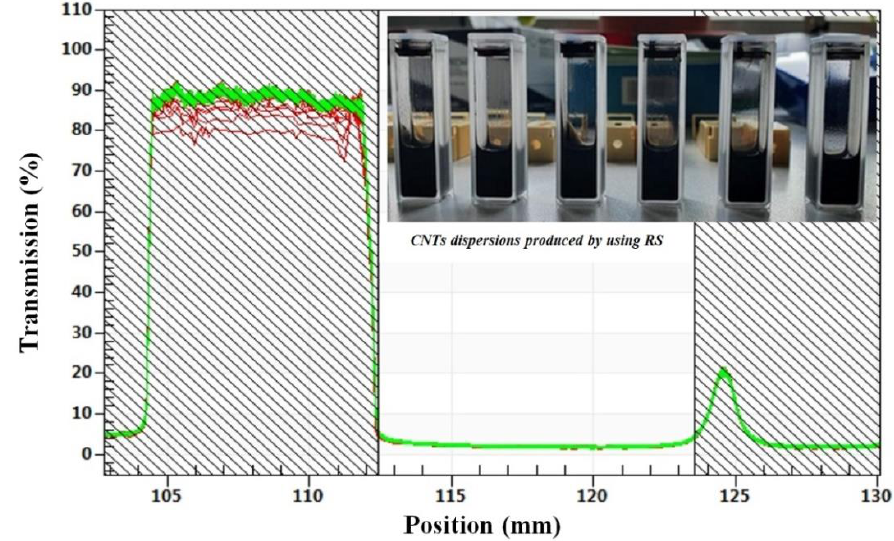
Figure 9. Transmission profiles for representative RS method CA/MWCNTs samples after centrifugation for 2.5 h in LuMiSizer equipment exhibiting no sedimentation or instability.